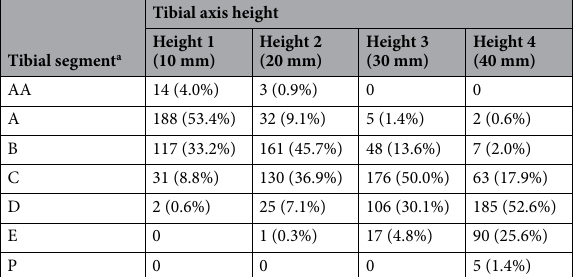
Tibial axis height